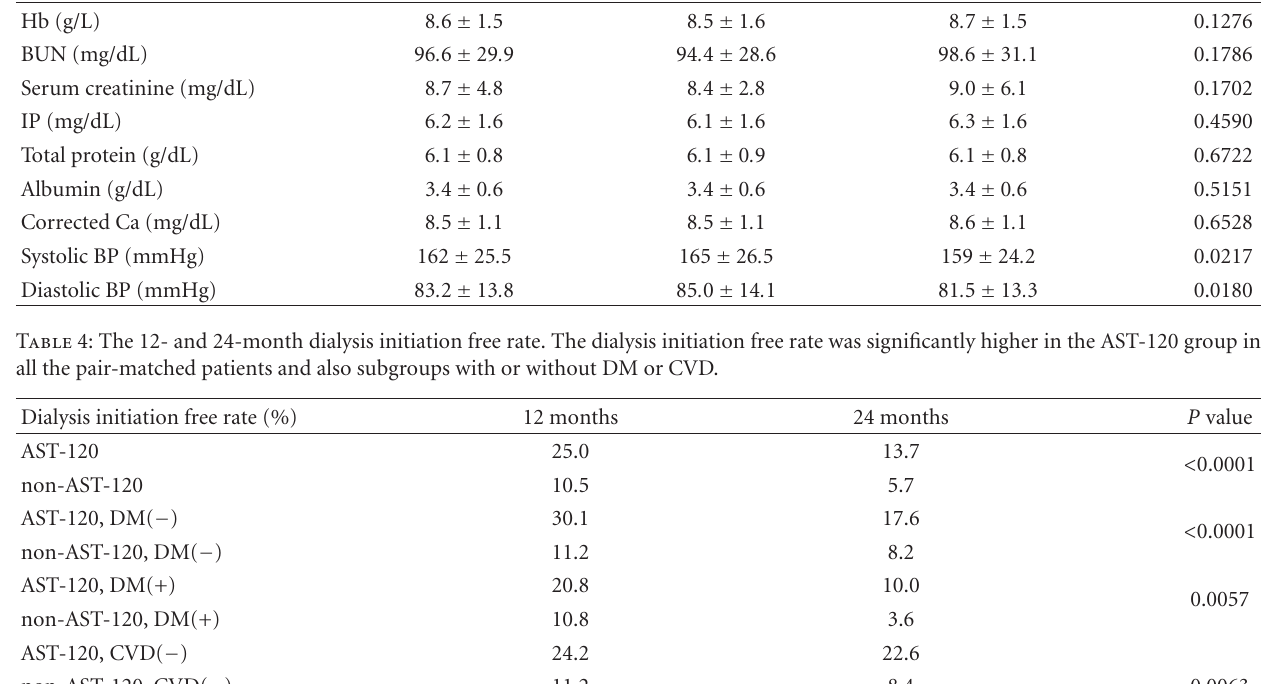
Table 3: The e ff ect of AST-120 on blood pressure, blood, and serum data at the time of dialysis initiation. At the time of HD initiation